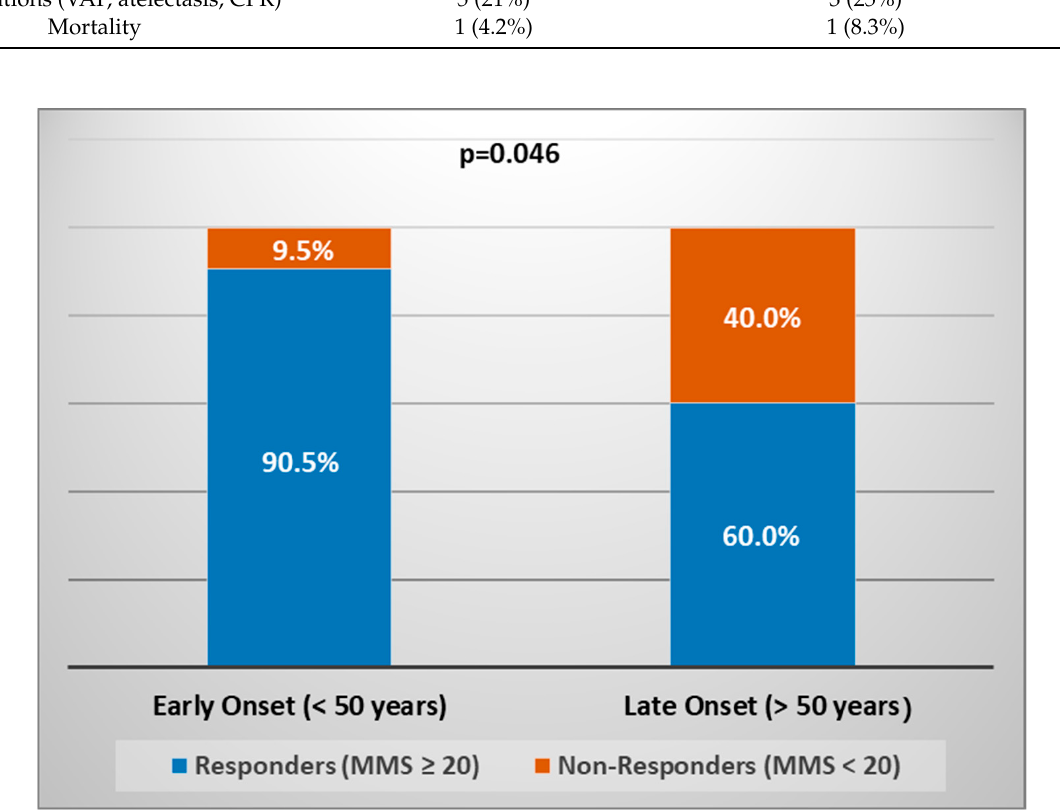
Figure 1. Proportions of responders and non-responders in early-onset ( n = 21) and late-onset ( n = 15) MG patients (MMS—Myasthenia Muscle Score).